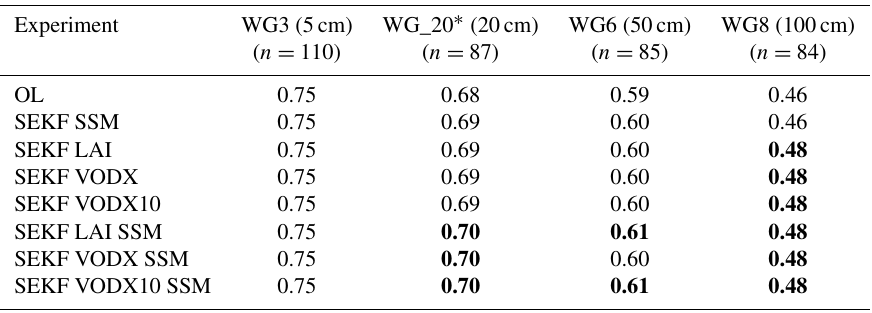
Table 3. Average correlations scores between USCRN in situ soil moisture observations and LDAS-Monde soil moisture at 5, 20, 50, and 100cm depths. Bold values indicate the highest score at each